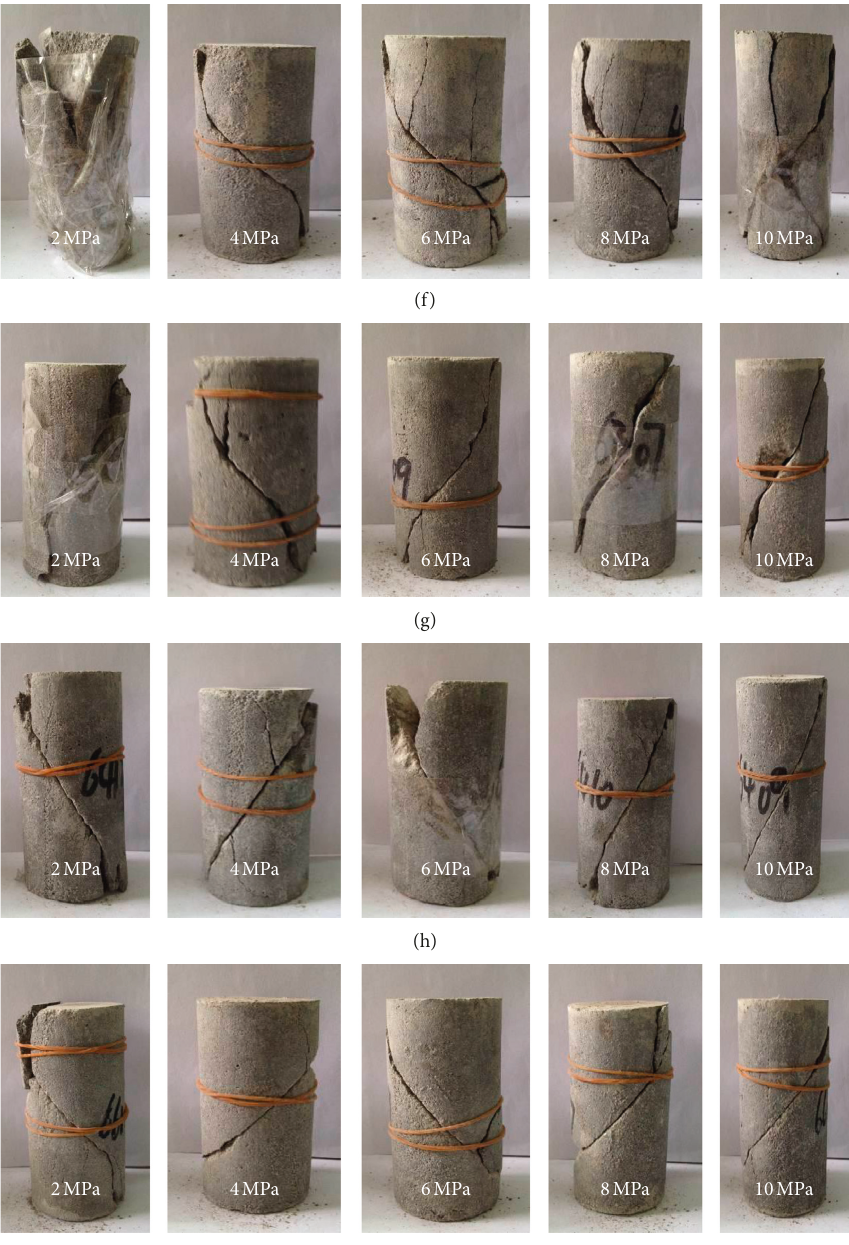
Figure 7: Sample failures under different pressures (joint orientation defined as β ; joint connectivity rate defined as k ): (a) β � 30 ° , k � 0.3; (b) β � 30 ° , k � 0.45; (c) β � 30 ° , k � 0.6; (d) β � 45 ° , k � 0.3; (e) β � 45 ° , k � 0.45; (f) β � 45 ° , k � 0.6; (g) β � 60 ° , k � 0.3; (h) β � 60 ° , k � 0.45; (i) β � 60 ° , k �